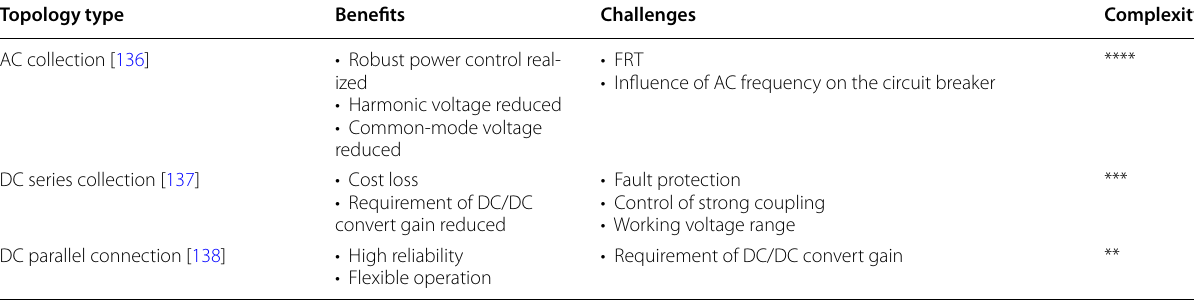
Table 8 Topologies and characteristics of the offshore step-up substation Topology